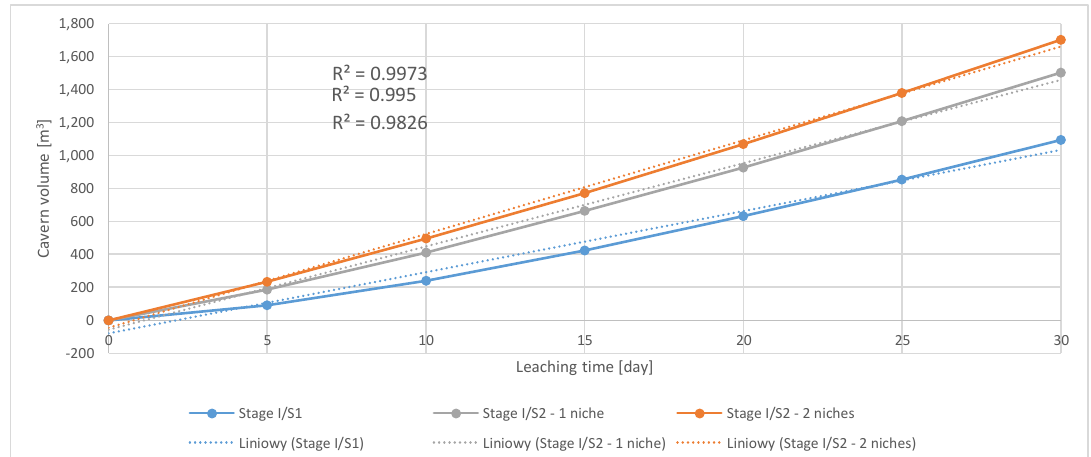
Figure 9. Comparison of the change in cavern volume for stage I for different scenarios.